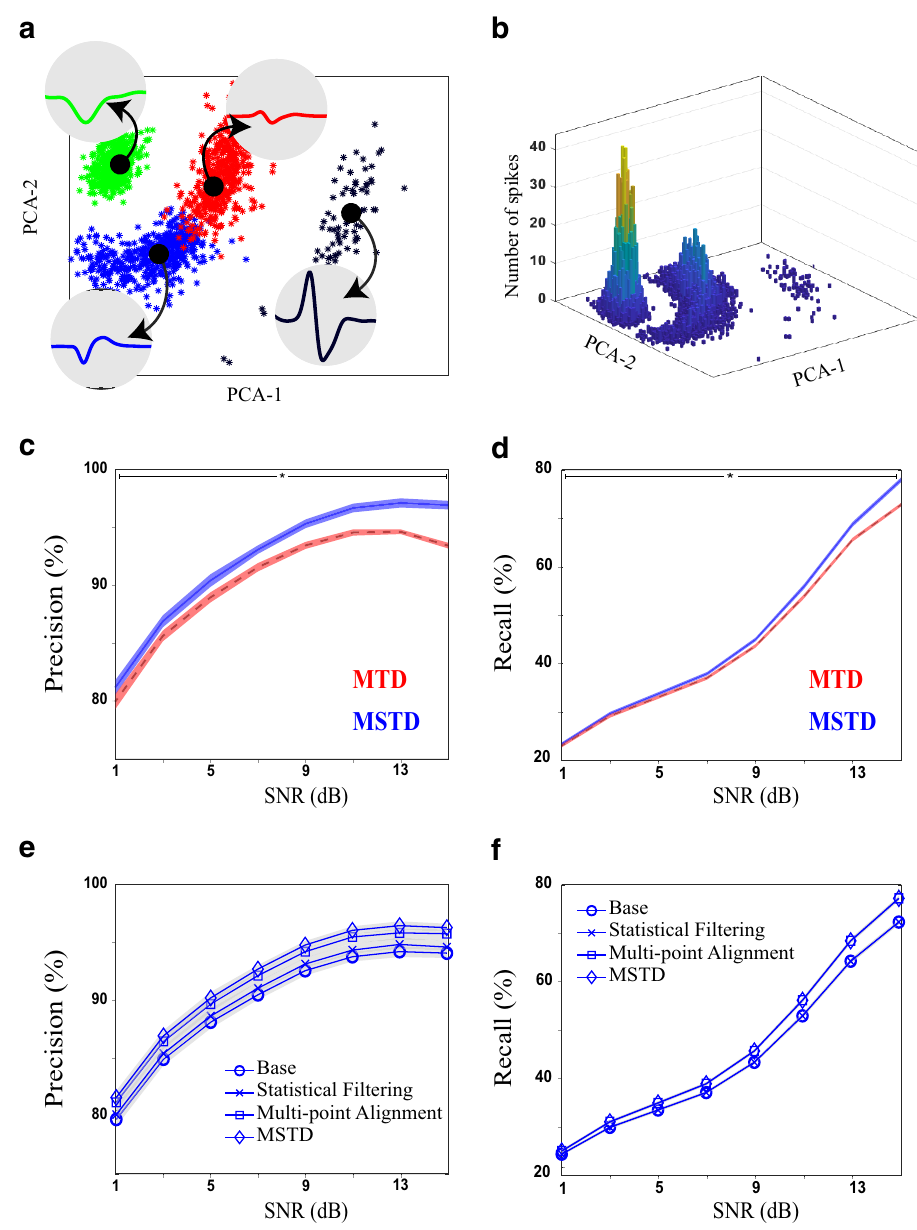
Figure 4. Evaluating the detection phase of the MSTD algorithm using synthesized dataset 35,36 in the detection phase. The dataset contains 200 sessions of 200-s recording with a sampling rate of 40 kHz. ( a ) A sample session is visualized using its two first principal components. There exist four distinct neurons distinguished by four colors. The average waveform of each neuron is also indicated in a 1.2-ms interval. ( b ) A sample distribution of spike waveforms. The x and y axes are the first two principal components of waveforms and the z-axis is the frequency of spikes. ( c , d ) Evaluating the proposed detection (multi-point alignment, and statistical filtering procedures). The precision ( c ) and recall ( d ) of MSTD in the detection phase is compared with MTD. The shaded area is the standard deviation. The horizontal line with the star shows where the values differ significantly. ( e , f ) The effect of statistical filtering and multi-point alignment on detection performance in terms of precision and recall. The MSTD method without any alignment and noise removal is depicted by "Base". The effect of multi-point alignment is higher than statistical filtering. In terms of recall, since statistical filtering only deals with false alarms, it has no effect on the